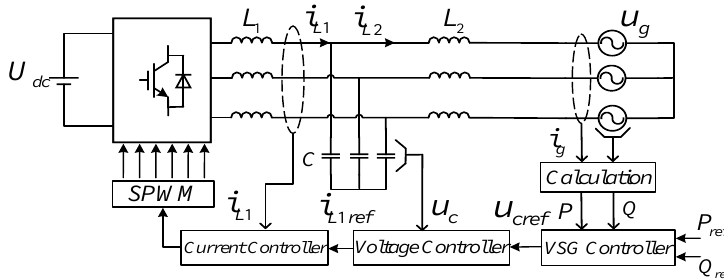
Figure 1. Schematic diagram of a virtual synchronous generator (VSG).